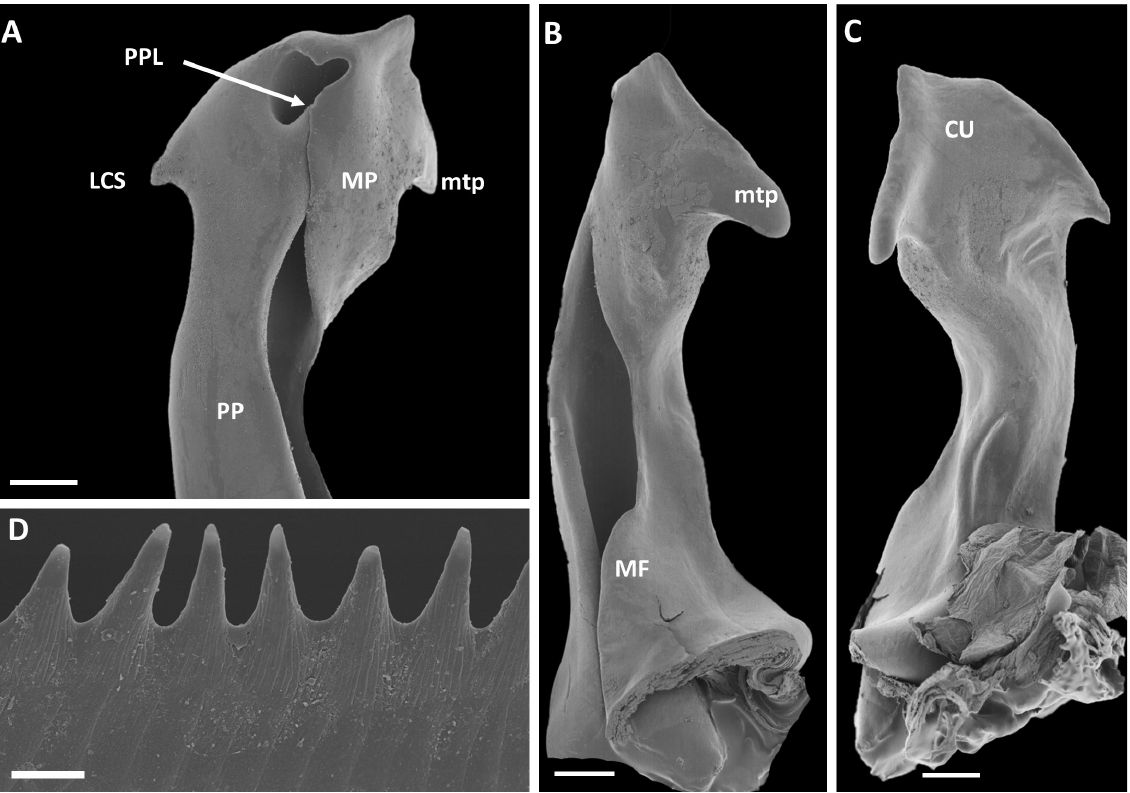
Fig. 17. Calyptomastix vuasu sp. nov., holotype, ♂ (NHMD 621717). A–C . Left gonopod coxa. A. Anterior view. B. Mesal view. C. Posterior view. D . Midbody dorsal limbus. Abbreviations: CU = cucullus; LCS = lateral coxal process; MP = metaplica; mtp = metaplical triangular process; PP = proplica; PPL = proplical lobe. Scale bars: A–C = 0.2 mm; D = 0.01